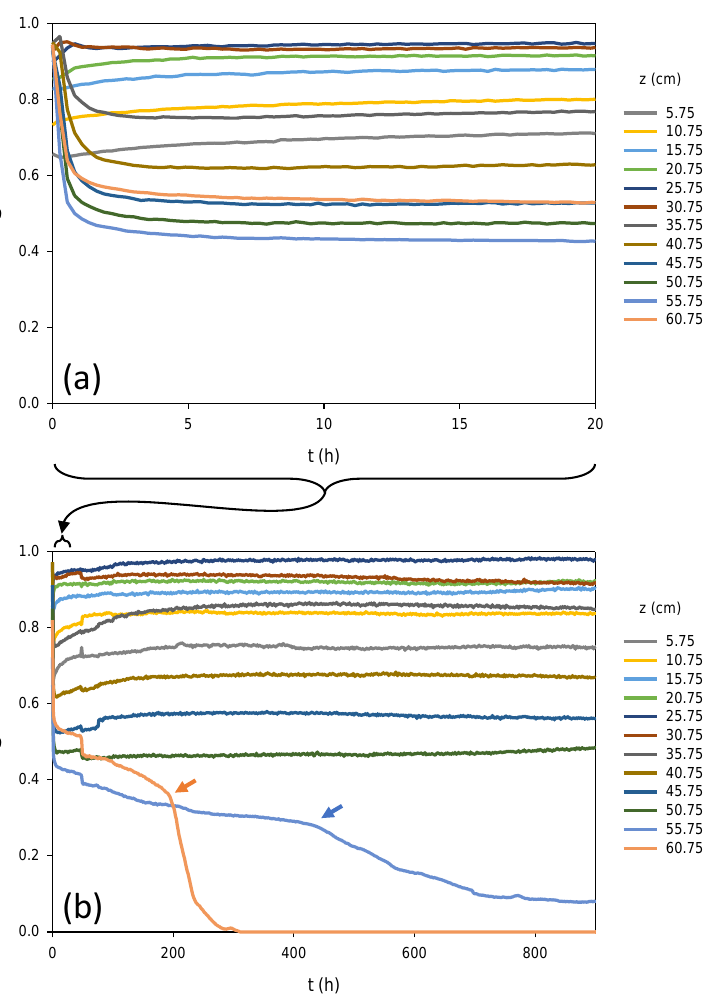
Figure 4. Saturation at the twelve sensors over short ( a ) and intermediate ( b ) timeframes at the start of the drainage experiment. Sensor elevation (z) is reported from the water table. Arrows indicate when the evaporative drying front from the top of the column reached the top two sensors.